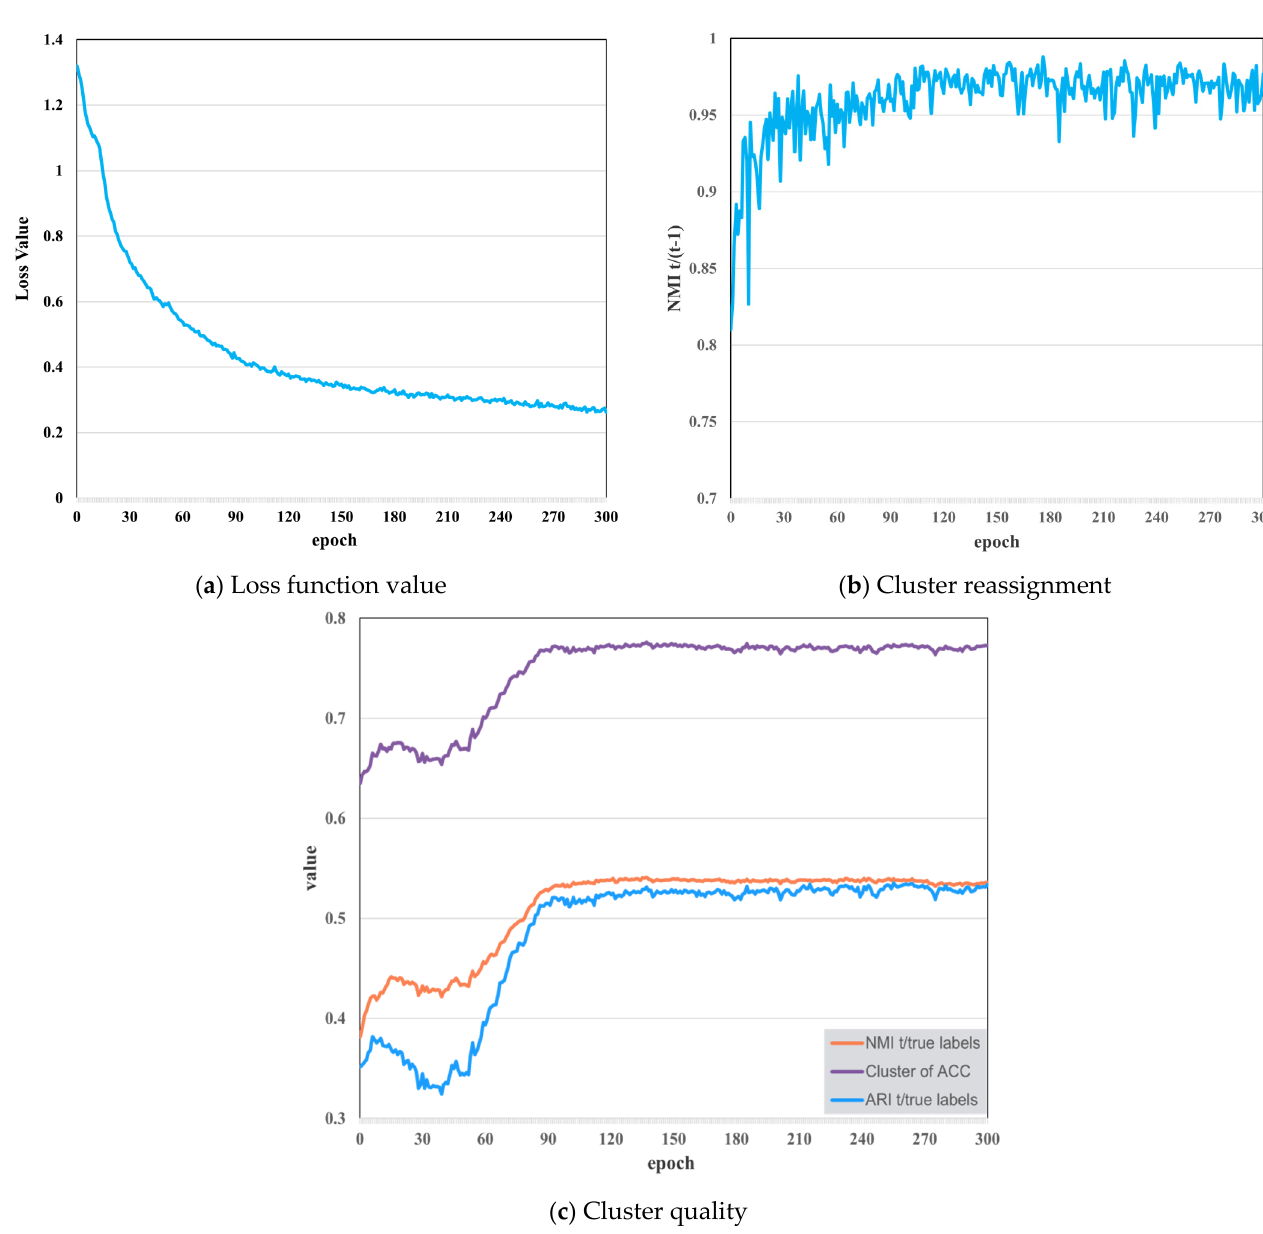
Figure 5. The preliminary studies of the random initial cluster centers experiment on the Reunion Island Dataset. ( a ) Loss function; ( b ) cluster reassignment; ( c ) cluster